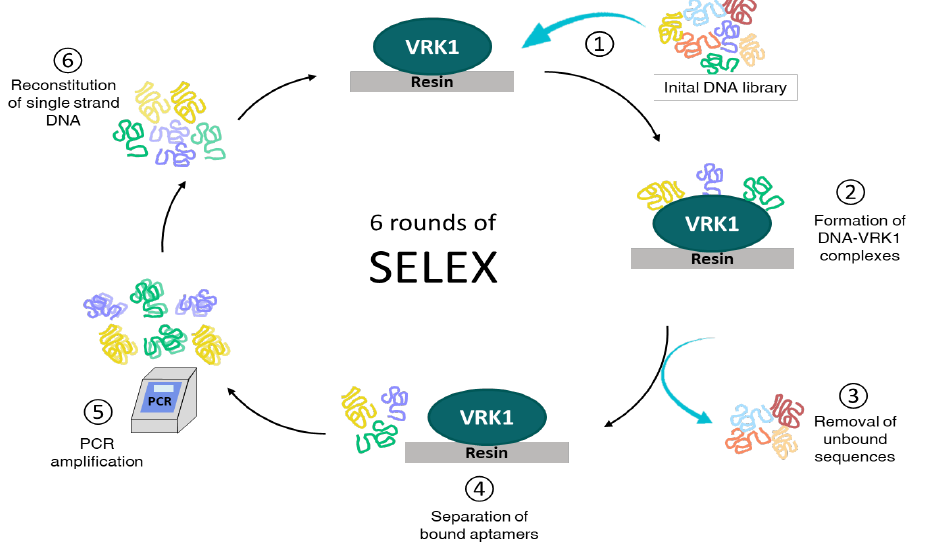
Figure 6. SELEX process used for VRK1 aptamers